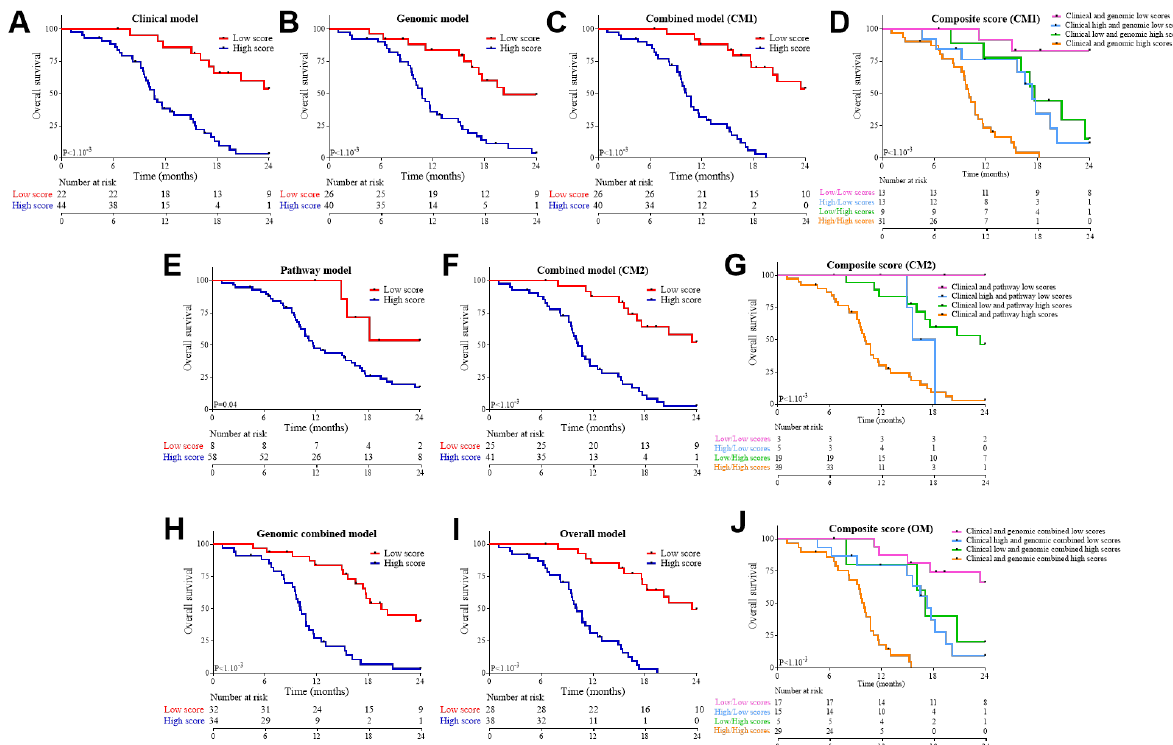
Figure 2. Description of the clinical, genomic, pathway, and combined models for overall survival in the FOLFIRINOX group. Kaplan–Meier curves for overall survival with patients stratified according to the clinical score ( A ), the genomic score ( B ), the combined model 1 (CM1) score ( C ), the low vs. high score (a composite score combining clinical and genomic scores) ( D ), the pathway score ( E ), the combined model 2 (CM2) score ( F ), a composite score combining clinical and pathway scores ( G ), the genomic combined score (genomic variables and pathways) ( H ), the overall score ( I ), and a composite score combining clinical and genomic combined scores ( J ).